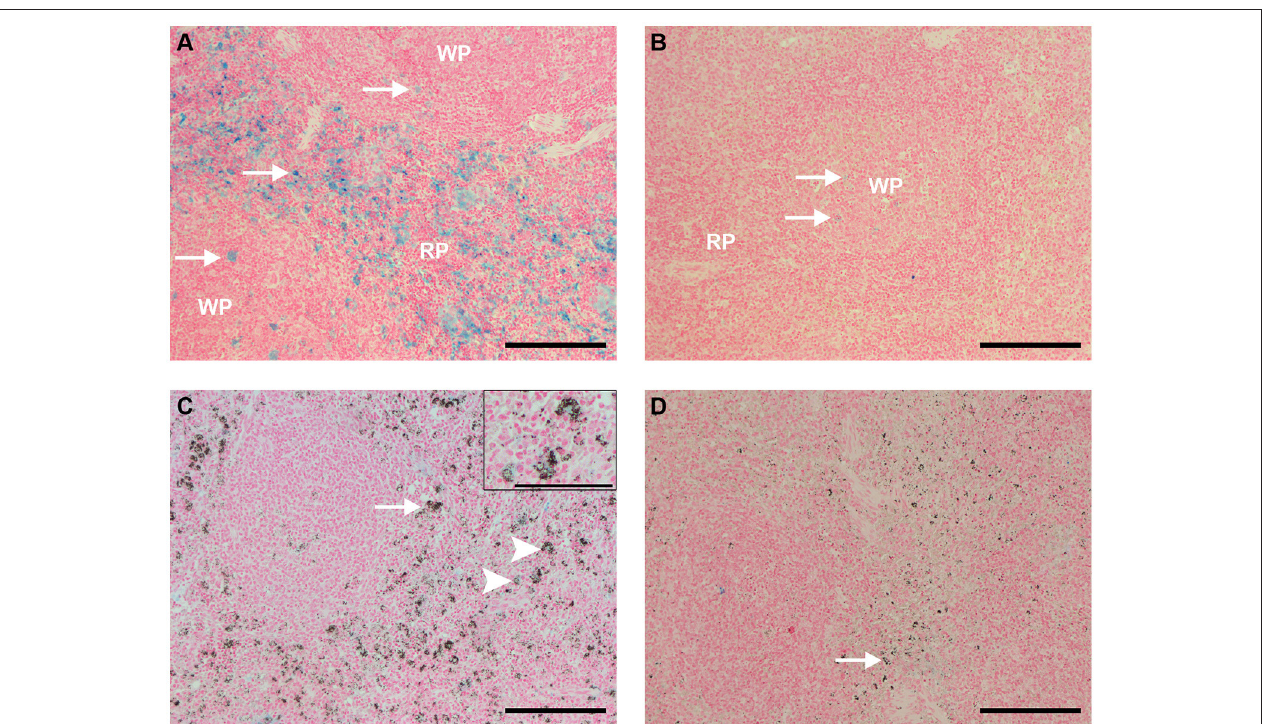
FIGURE 7 | Spleen sections Perls staining (bar: 200 µ m, except in C , bar: 100 µ m). (A) Spleen of an uninfected, control animal that received PBS (code PA11). Large amounts of ferric iron-containing macrophages (blue staining) were observed throughout the red pulp (RP), and also sparsed in follicles (arrows). (B) Spleen of an uninfected Saimiri inoculated with CL 1 mL (code PB75). Blue staining, representing ferric iron-containing macrophages, nearly disappeared from the red pulp (RP), and was faint in follicles (arrows). (C) Spleen of a P. falciparum -infected Saimiri that received PBS (code 216: treated at day 17, with 1,3% parasitemia, killed 5 days later). Blue staining, representing ferric iron-containing macrophages, was much fainter in the spleen of infected, compared to uninfected, S. sciureus ; on the other hand, macrophages were laden with hemozoin (arrow); only few macrophages showed colocalization of iron staining and hemozoin (arrowheads and magnified insert on top right). (D) Spleen of a P. falciparum -infected Saimiri that received CL 1 mL (code 272: treated at day 11, with 22% parasitemia, killed 5 days later). Presence of iron staining was nearly absent, and presence of hemozoin (arrow) was much decreased in relation to (C)